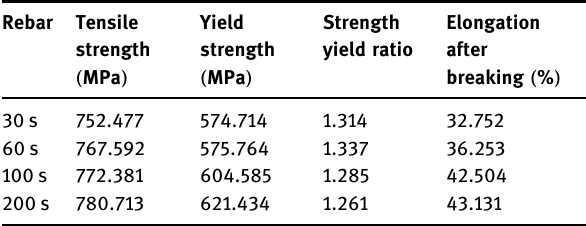
Table 4: Tensile data of the experimental rebar under di ff